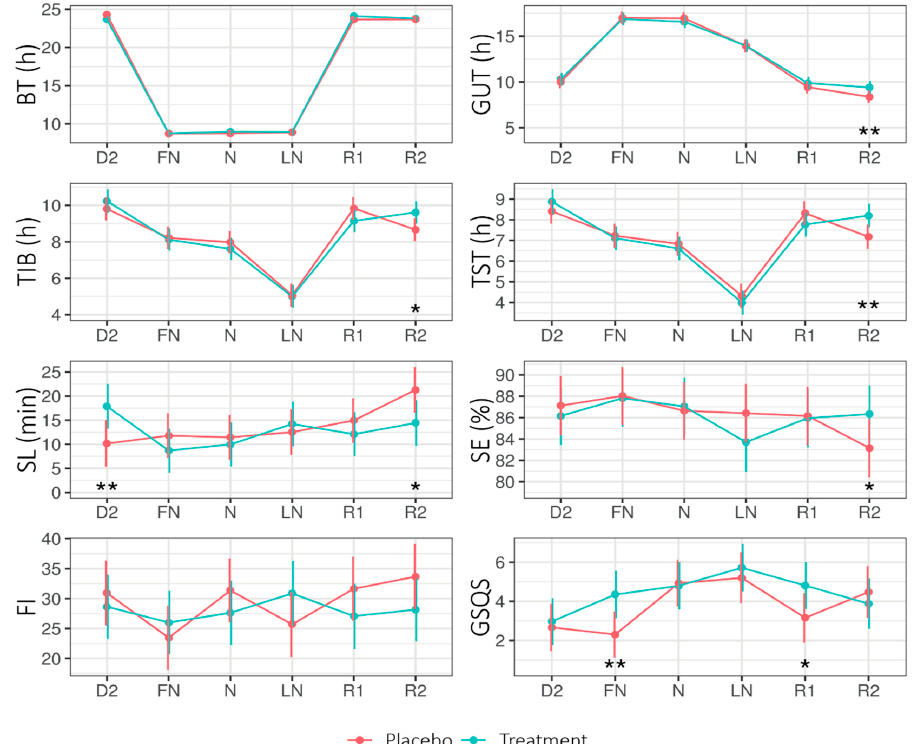
Figure 3. Estimated marginal means (EMM) of bed time (BT), get-up time (GUT), time in bed (TIB), total sleep time (TST), sleep latency (SL), sleep efficiency (SE), fragmentation index (FI), and Groningen Sleep Quality Scale (GSQS) score across Daytype for the placebo and treatment condition. Error bars indicate the 95% confidence intervals of the estimated marginal means. D2 = night before nightshift, FN = first night of nightshift, N = nightshift, LN = last night of nightshift, R1 = first recovery day, and R2 = second recovery day. * = p < 0.05, ** = p < 0.01.